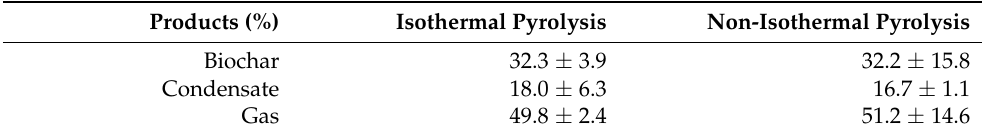
Table 1. Comparative mass yields of pyrolysis products (as-received basis) in isothermal and non-isothermal